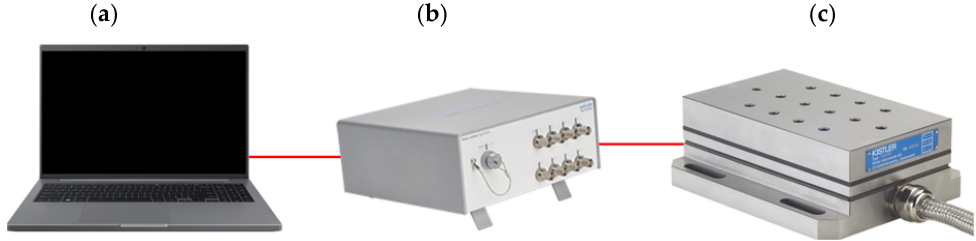
Figure 5. Measuring devices used to measure the force effects in turning: ( a ) PC; ( b ) LabAmp 5167A Laboratory Charge Amplifier DAQ; ( c ) 9257B dynamometer.